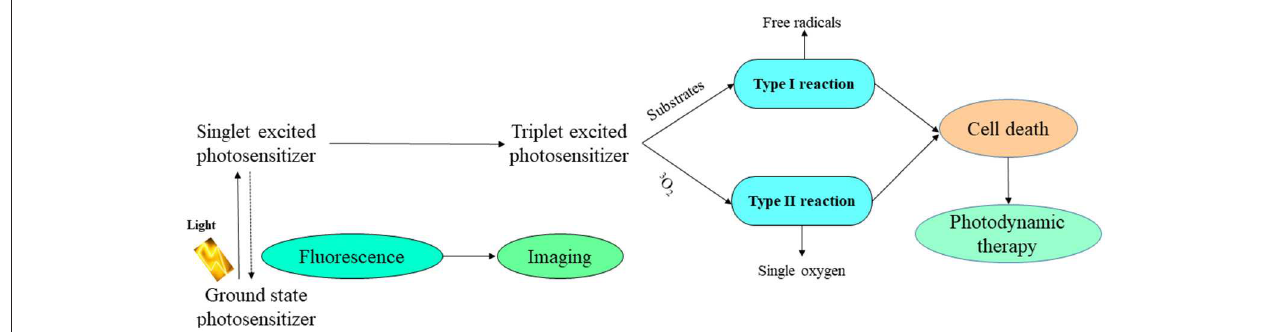
FIGURE 6 | Schematic photodynamic reaction. Adapted with permission Lucky et al. (2015) Copyright 2015, American Chemical Society.